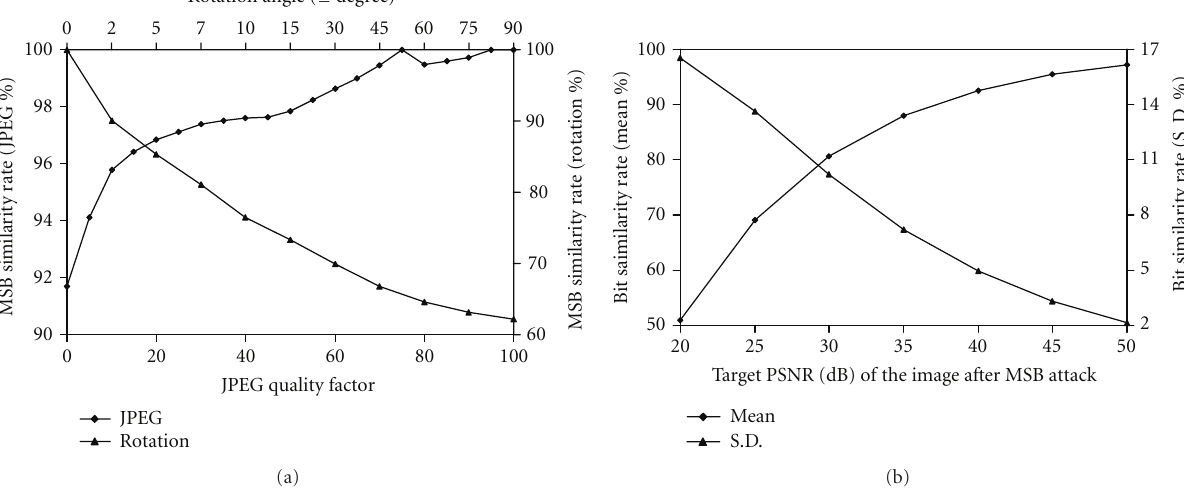
Figure 2: (a) Most significant bit (MSB) similarity rates of gray-scale image at di ff erent JPEG and rotation attacks; (b) mean and standard deviation of gray-scale MSB similarity under the newly proposed MSB attack. Note that the rotation angle axis in (a) is nonlinear.